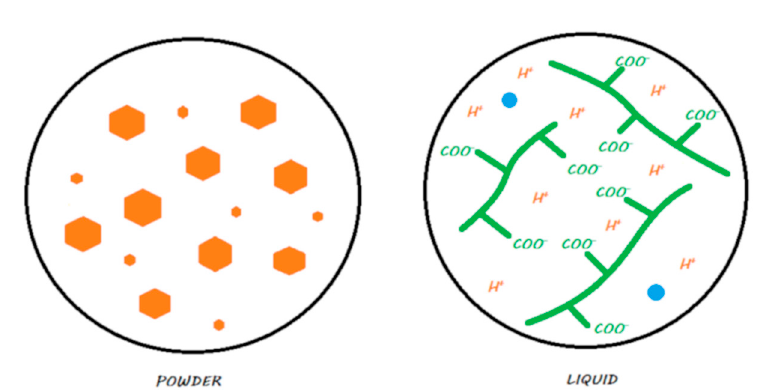
Figure 4. HV-GIC in its storage medium. The powder contains nonsilanated FAS fillers in which very small FAS fillers are added to speed up the reaction and increase the powder/liquid ratio. The liquid contains water and ionized polyacrylic acids.